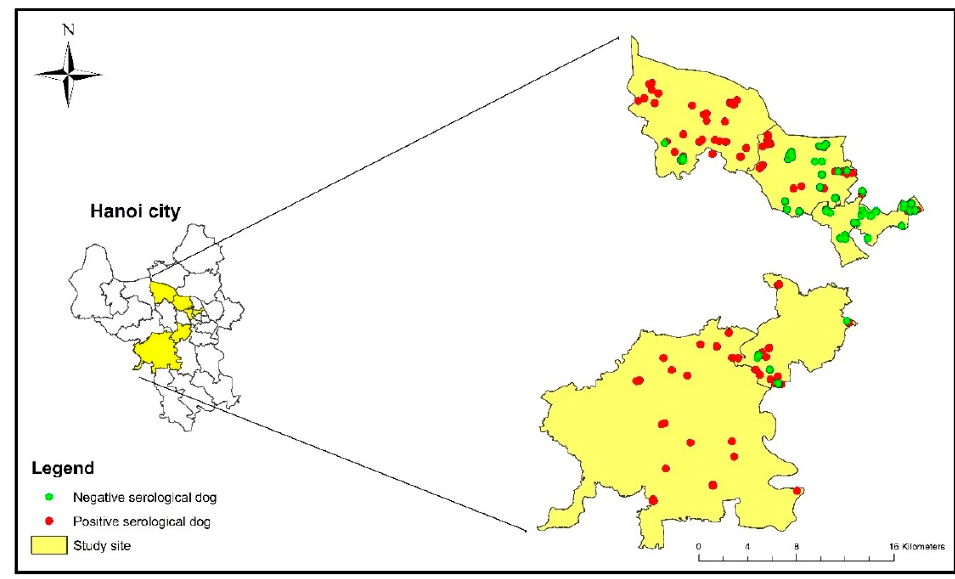
Figure 1. Distribution of flavivirus seroprevalence in dogs rising in Hanoi by cELISA.